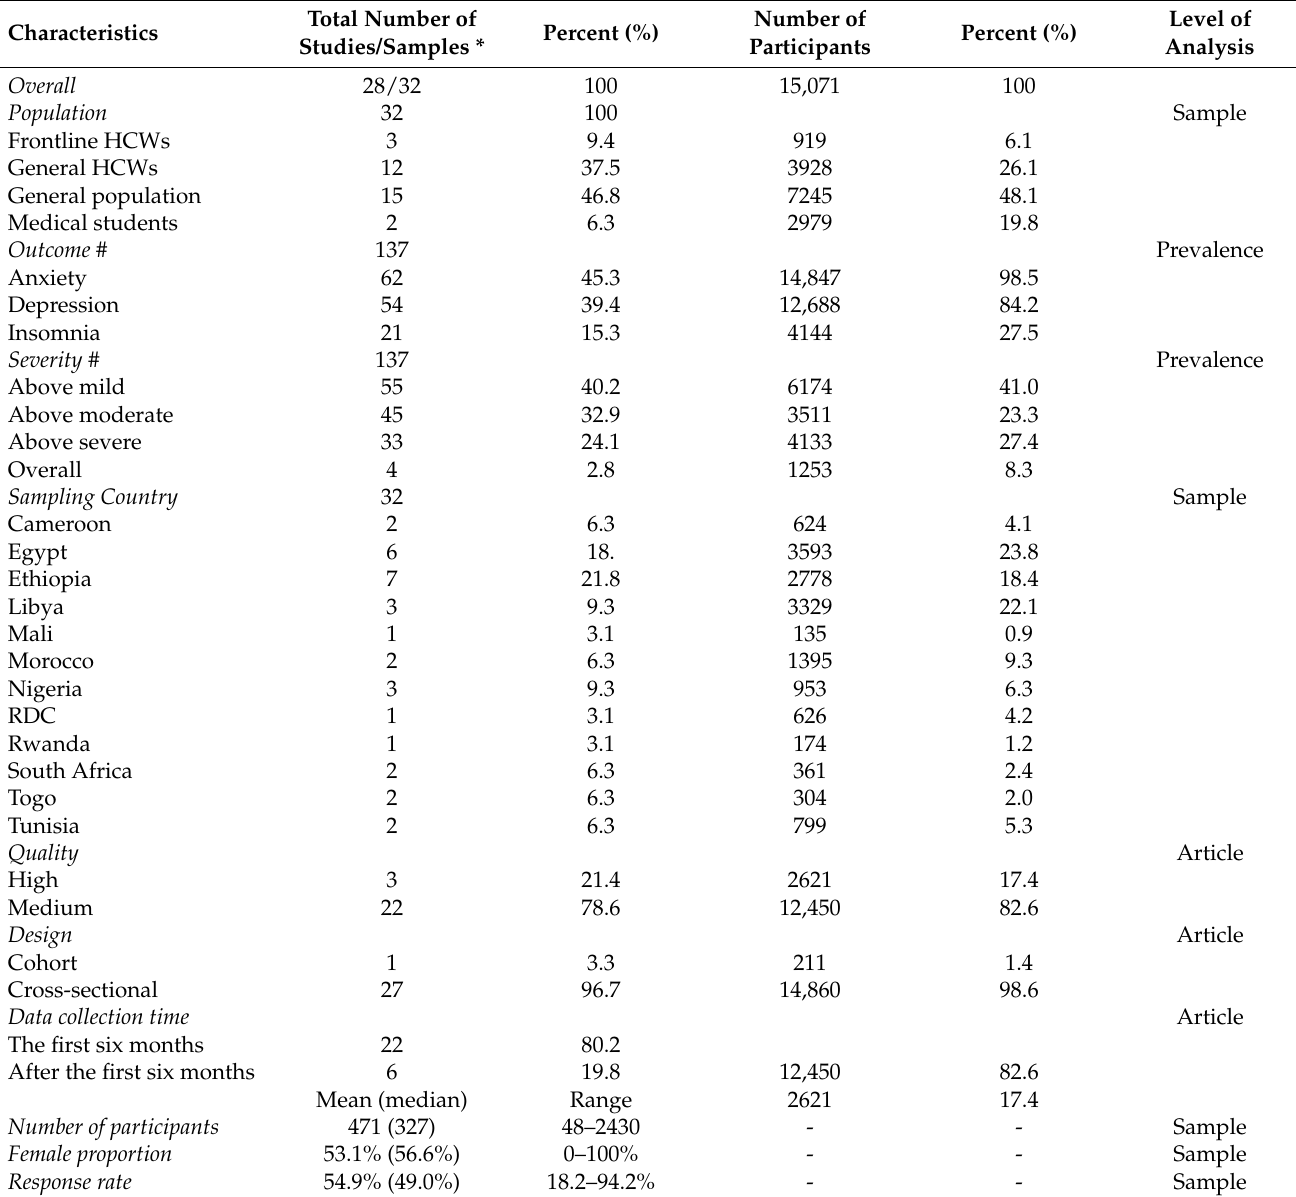
Table 1. Characteristics of the studies on mental health in Africa during COVID-19